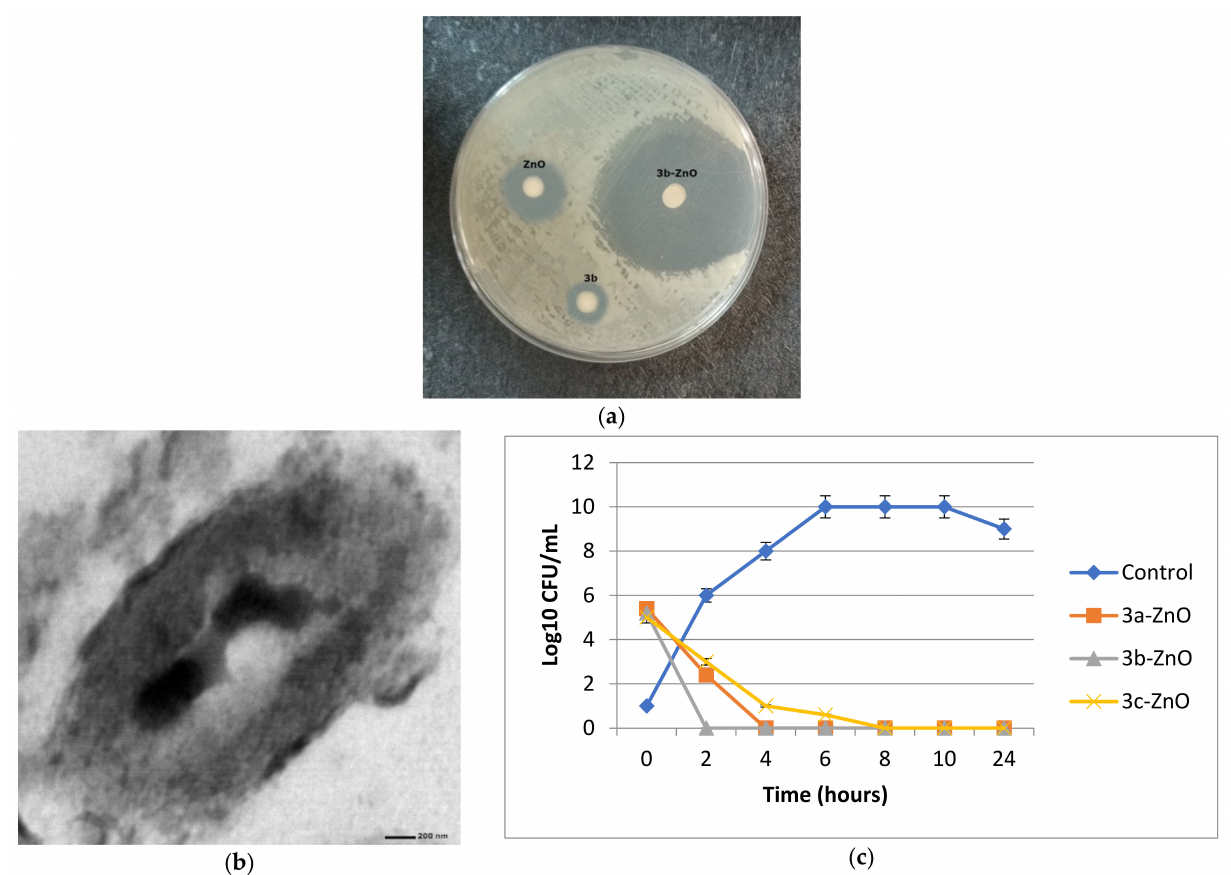
Figure 9. Antibacterial effect of the synthesized compounds and their hybrids against Kp5. ( a ) Disc diffusion method, ( b ) transmission electron microscopic study of Kp5 treated cell, and ( c ) time-kill